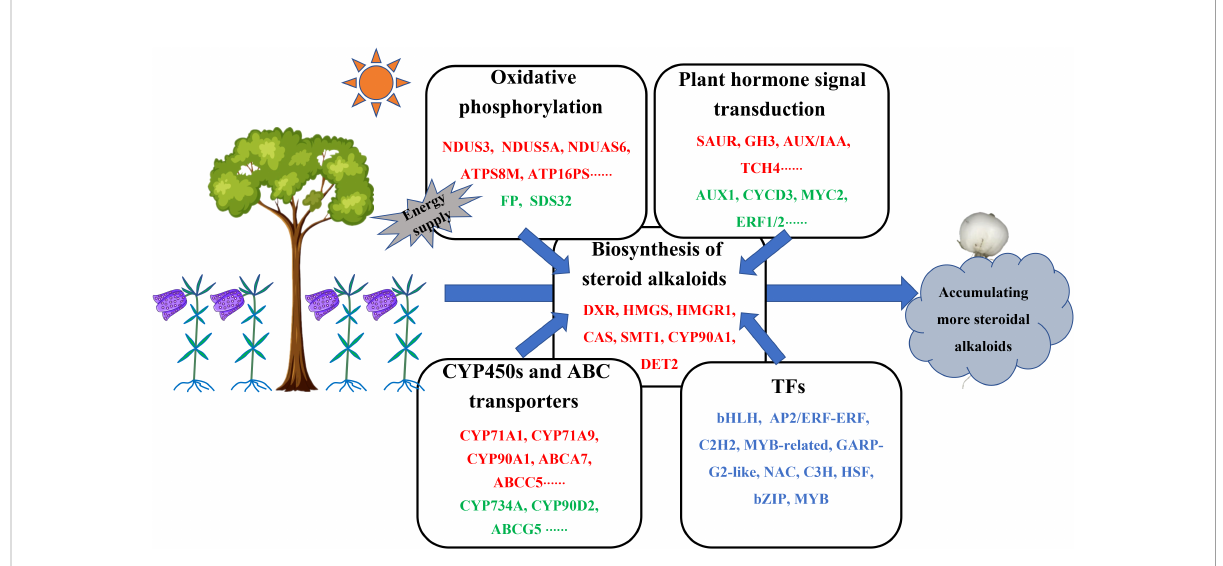
FIGURE 8 Proposed main molecular mechanisms of improving steroid alkaloids of F. hupehensis in response to the intercropping system. Up-regulated genes were denoted by red color, down-regulated genes were denoted by green color, both up-regulated and down-regulated genes were denoted by blue